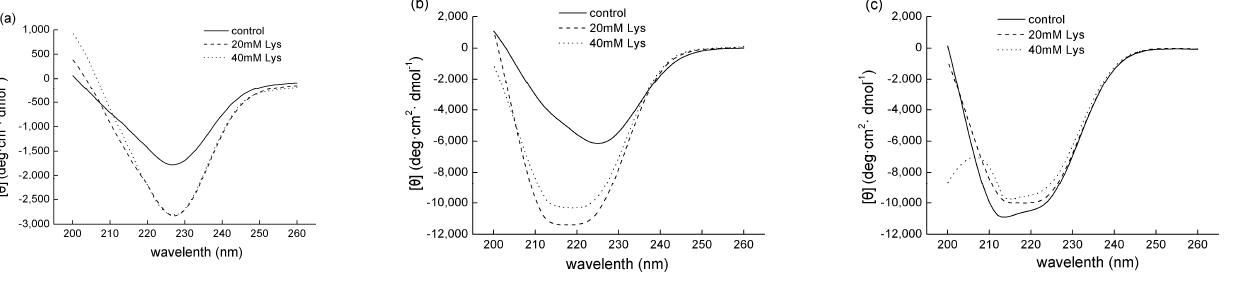
Figure 4. The effects of Lys on the CD spectra of MFP solutions at different ionic strengths. ( a ) The ionic strength of 0.15 M; ( b ) the ionic strength of 0.3 M; ( c ) the ionic strength of 0.6 M. control, treatment without Lys addition; 20 mM Lys, treatment with 20 mM Lys; 40 mM Lys, treatment with 40 mM Lys.